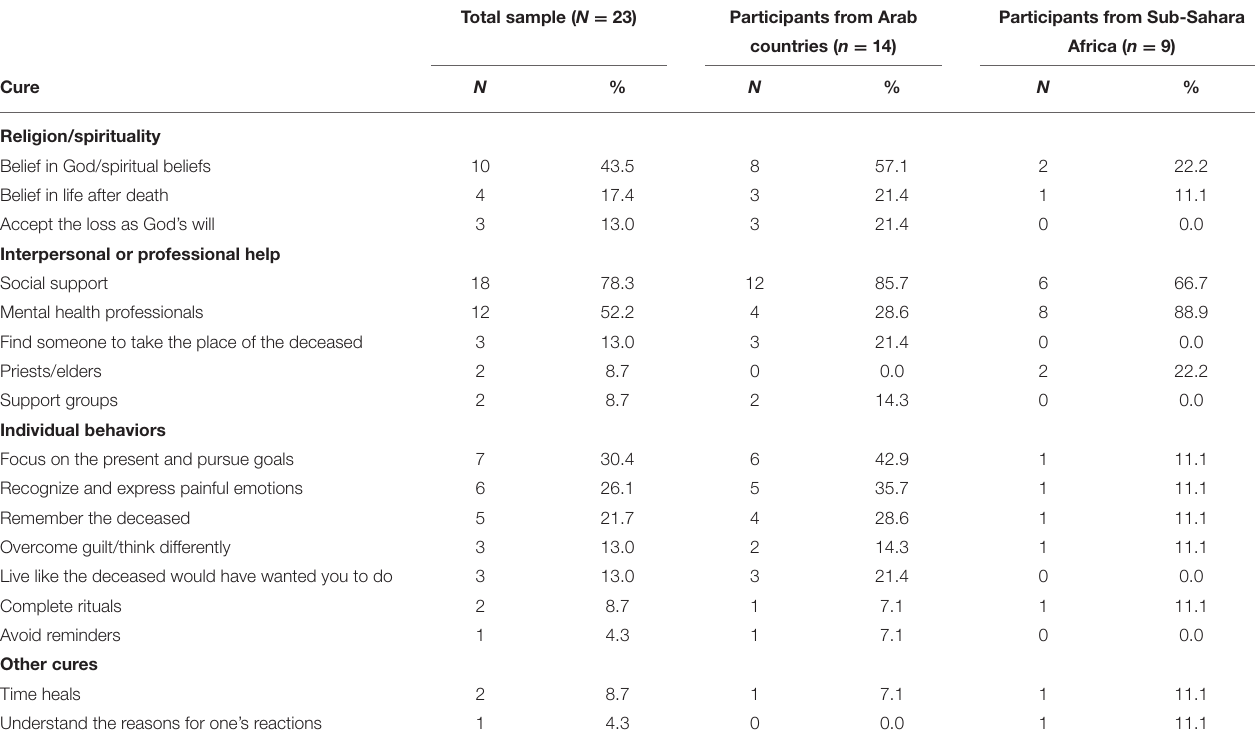
TABLE 4 | Cures of PGD